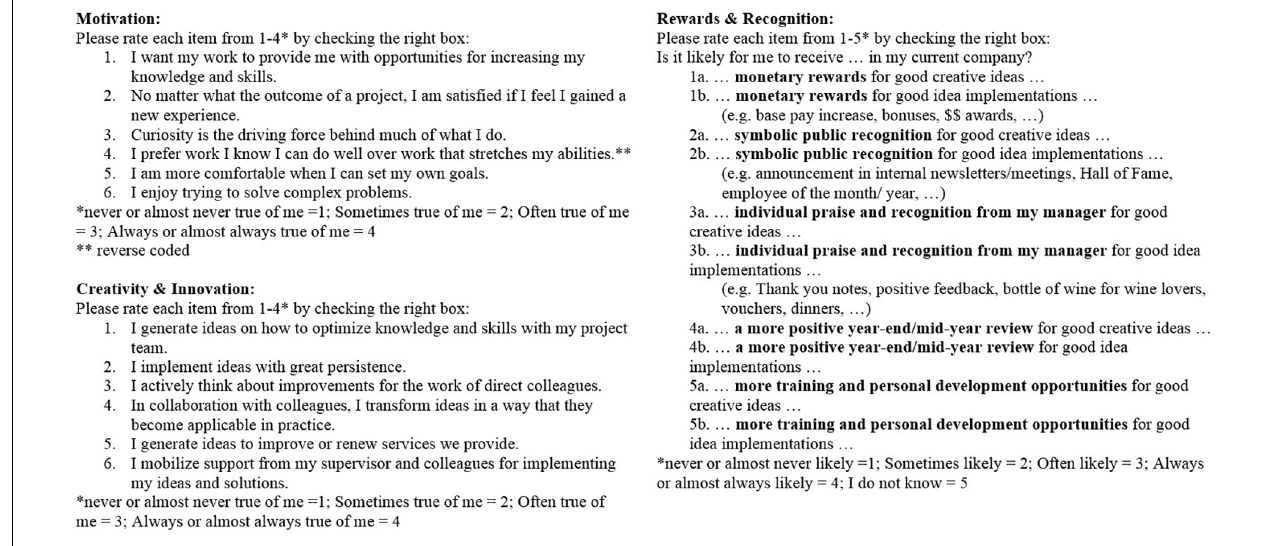
FIGURE 4 | Online self-evaluation questionnaire (Inquery).